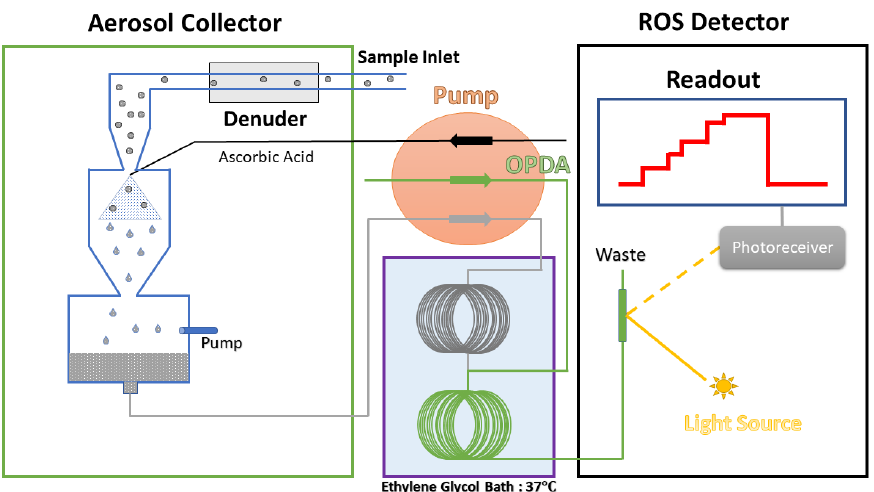
Figure 3. Simplified schematic illustrating the online AA method. (Adapted from Campbell et al. [52].)